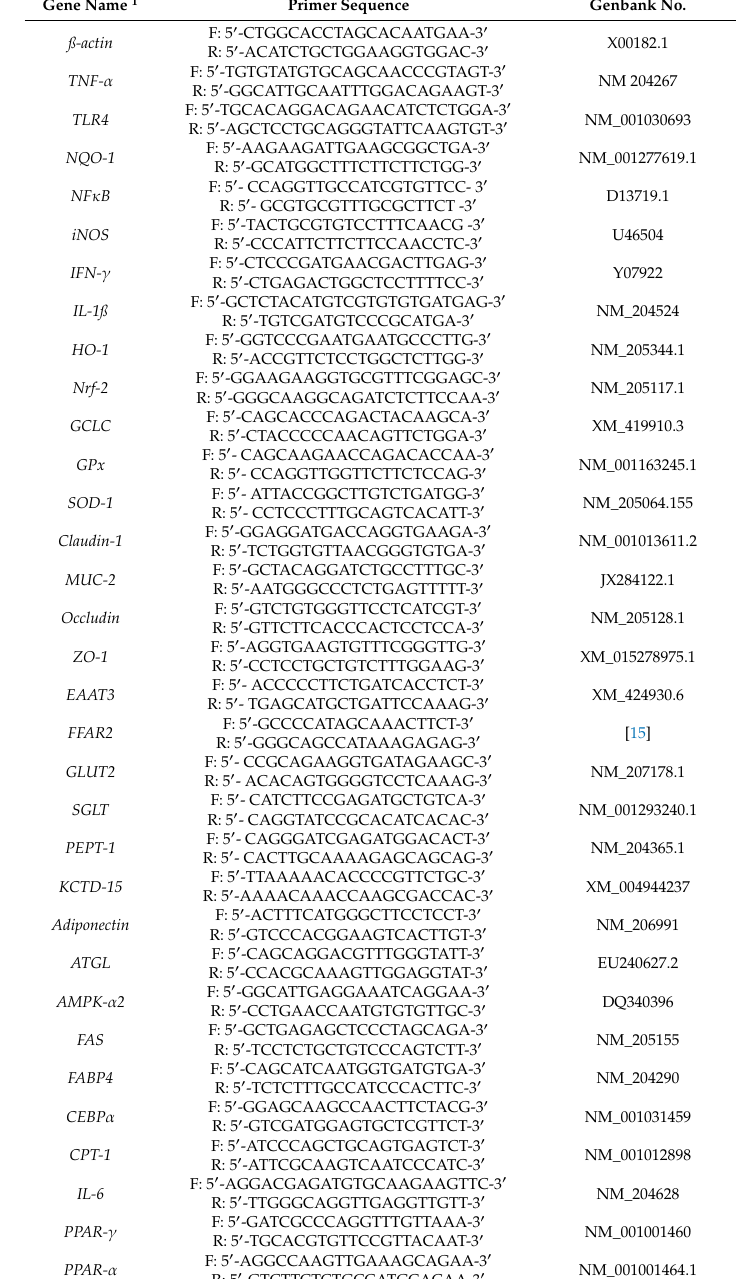
Table 2. The primer sequence of each gene according to Genbank or other